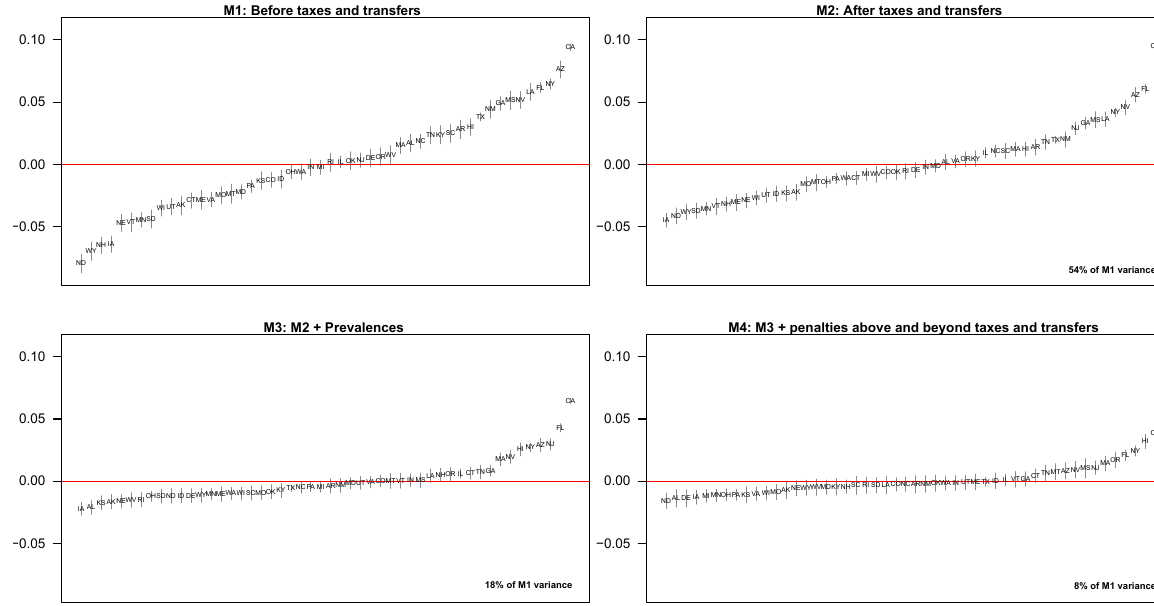
Figure 10: State random effects from hierarchical linear probability models predicting SPM poverty (2012– 2016 CPS). States are indicated by their postal code abbreviations. Adjustments for SNAP, SSI, and TANF underreporting were made using the Urban Institute TRIM. State random effects are estimated as deviations from the overall mean (the overall mean is estimated as a weighted average of the state means). All models include a control for the number of people in a houseold, metropolitan and/or nonmetropolitan status, and year fixed effects. Vertical lines represent 95 percent confidence intervals. States are indicated by their postal code